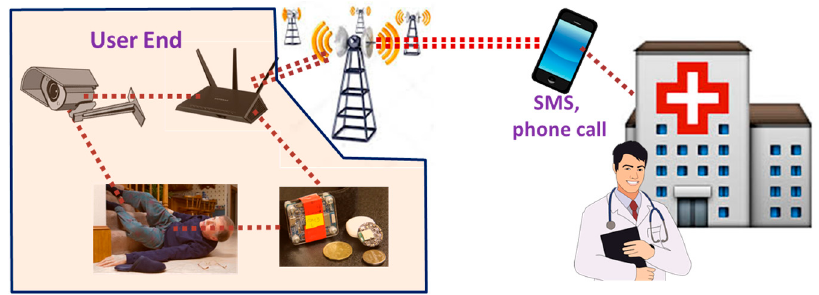
Figure 7. Remote fall detection system.